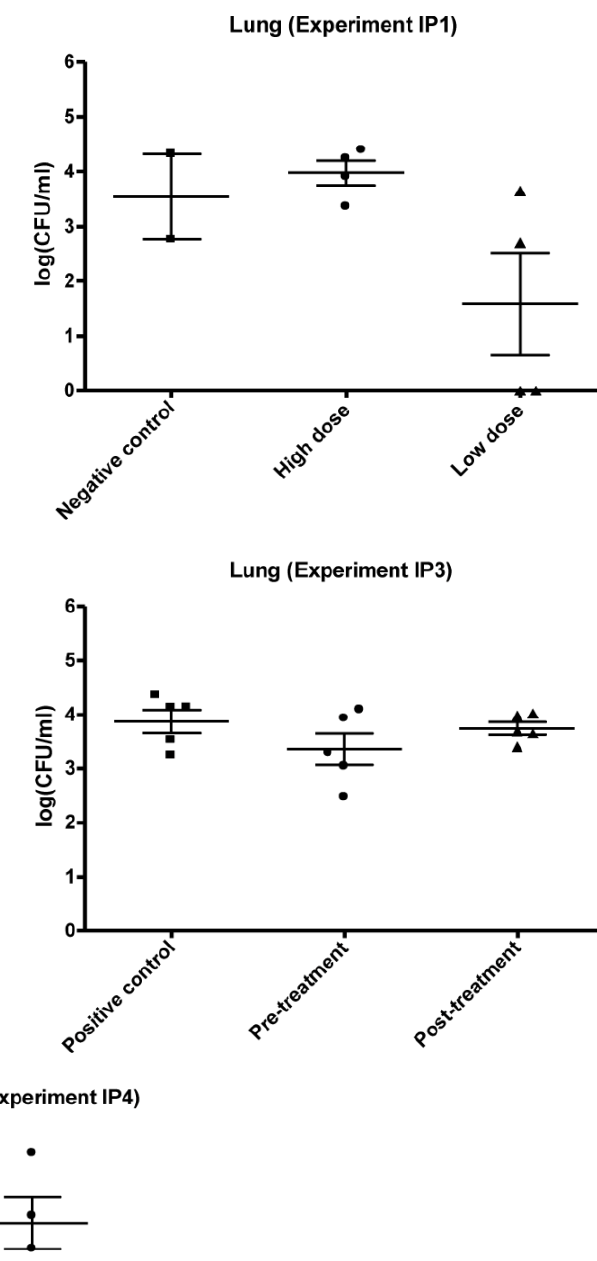
Figure 4. Results of mouse experiment IP0, IP1, IP2, IP3 and IP4: Scatter plots of bacteria detected in lungs after cultivation on 5% horse blood agar plates. The values are plotted as log CFU/mL. Group A IP0 not